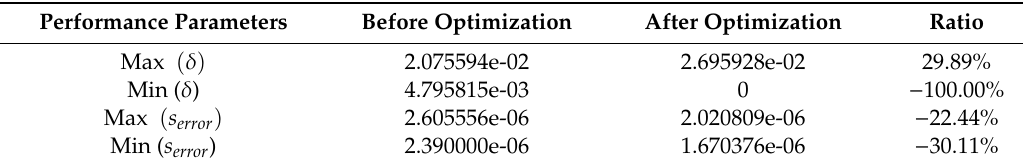
Figure 11. Comparison before and after optimization of human knee femur where ( a ) is regarding cusp height and ( b ) is the surface profile error regarding number of training iterations of CGAN. The results comparison for various layer amounts are listed in Table 1. Table 1. Results comparison for various layer amounts.